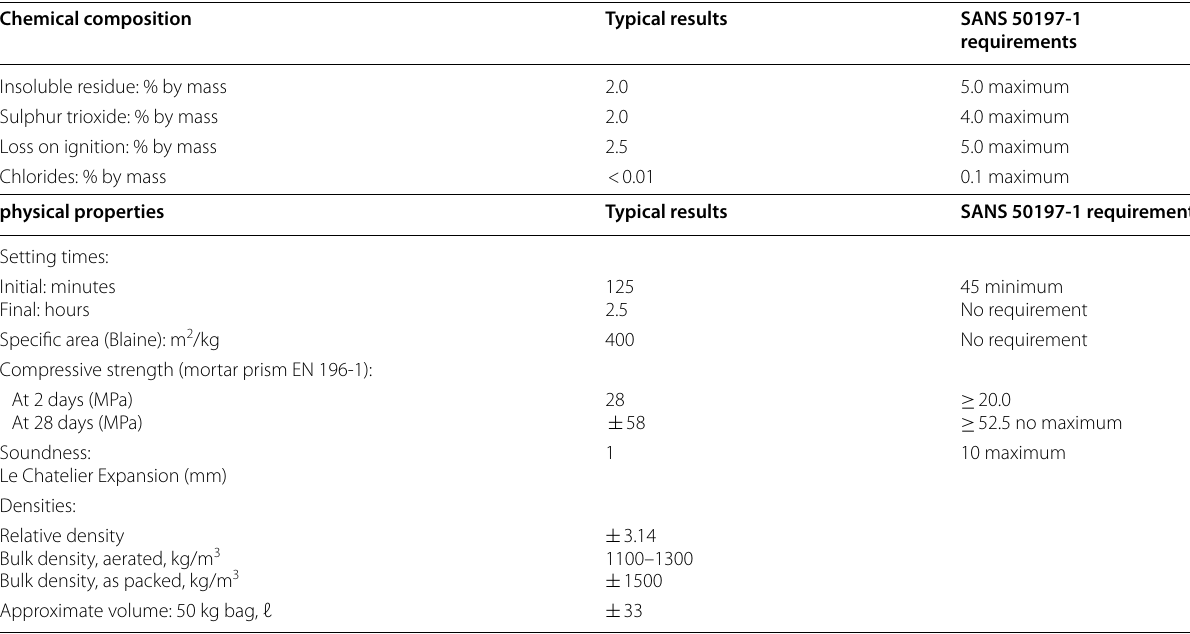
Table 1 Typical properties of the Portland cement used (CEM 1 52.5